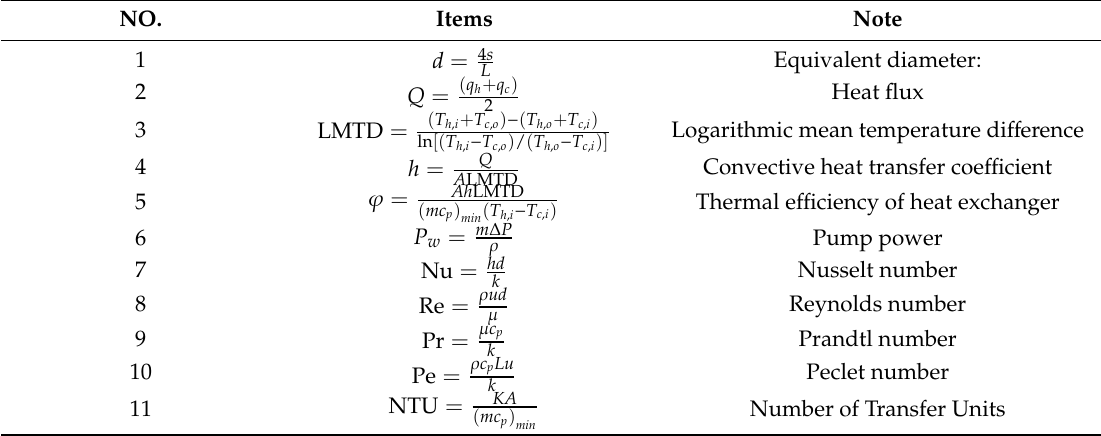
Table 4. Mathematical formulas used in the correlation analysis of this